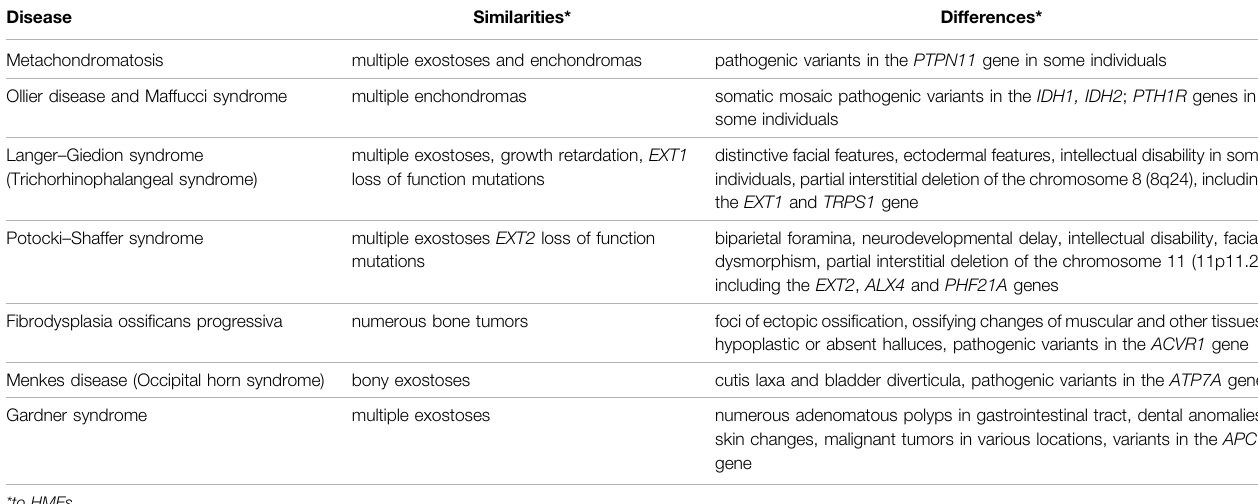
TABLE 2 | A comparison of hereditary multiple exostoses (HMEs) and other disorders presenting overlapping clinical features (Maas et al., 1993; Pignolo et al., 2013; McFarlane et al., 2016; Beyens et al., 2019; Jurik, 2020; Suster et al., 2020; Trajkova et al., 2020; Charifa et al., 2021).